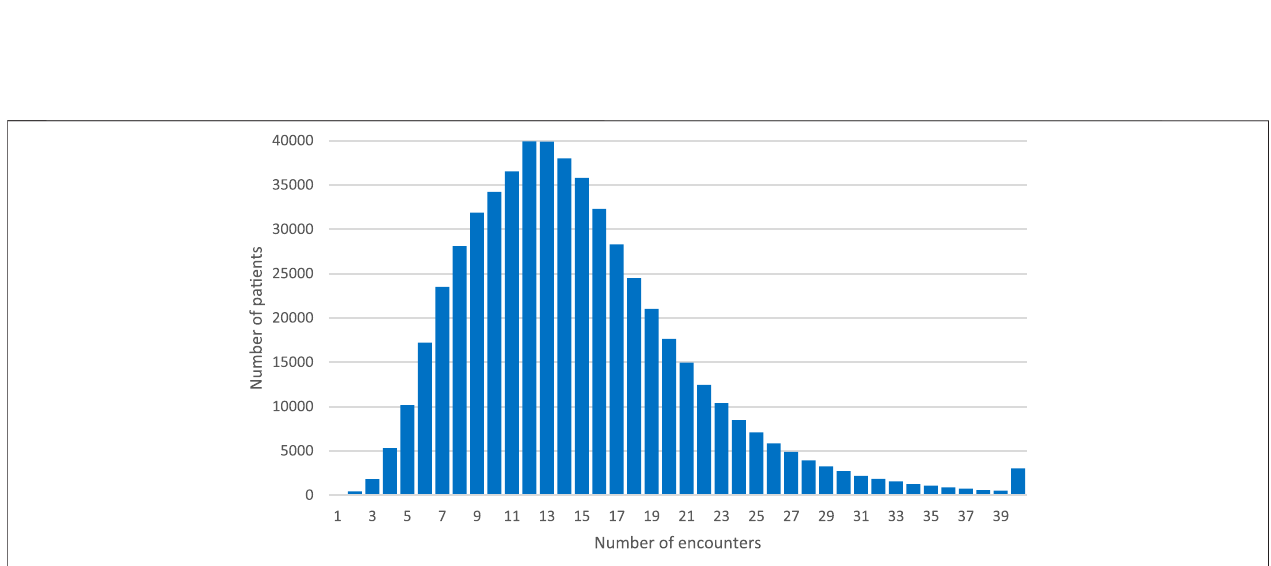
FIGURE 5 | Number of elderly patients on chronic polypharmacy in Poland in 2018 by number of encounters during which their prescriptions were issued.